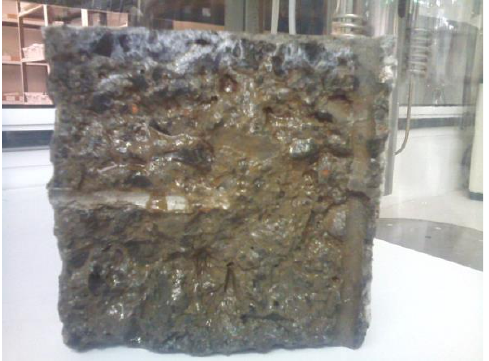
Figure 6. Chloride penetration profile revealed. The chloride penetration front can be seen in the upper part of the broken